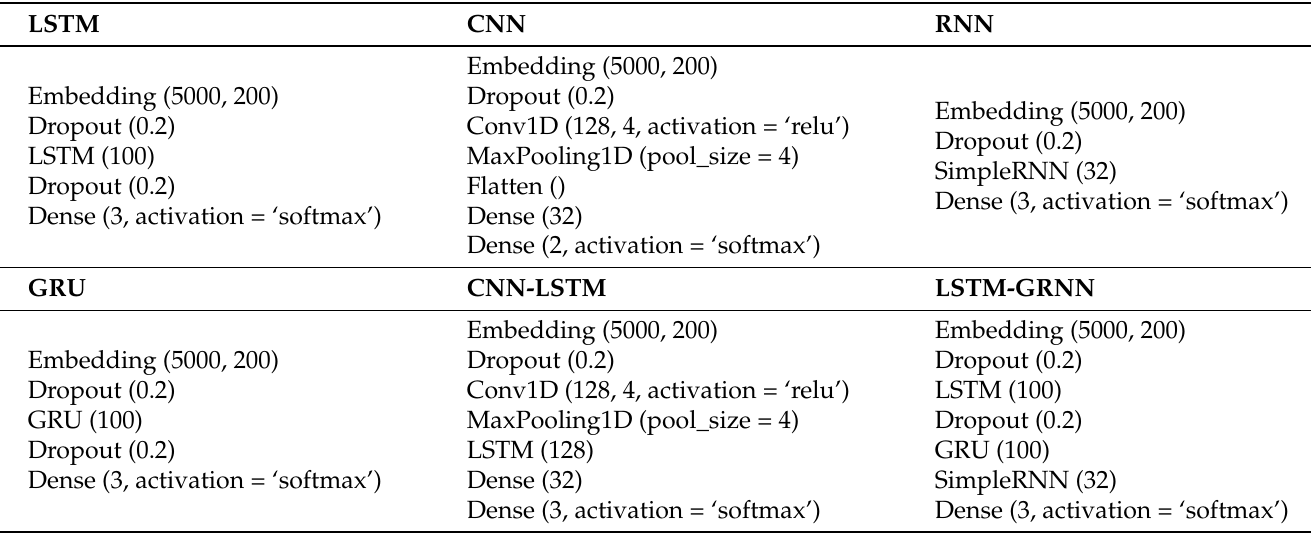
Table 9. Architecture of deep learning models.